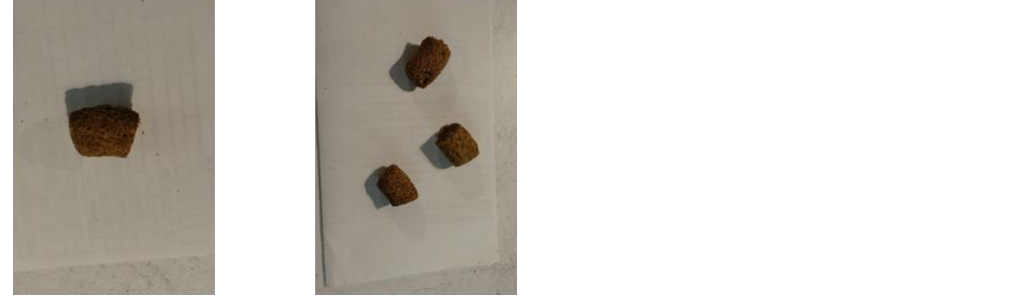
Figure 5 . A screen shot of chow images presented to the gorillas in Exp. 2 for the one versus three discrimination. A ‘zero’ image showed only the background of the paper against the table seen under the